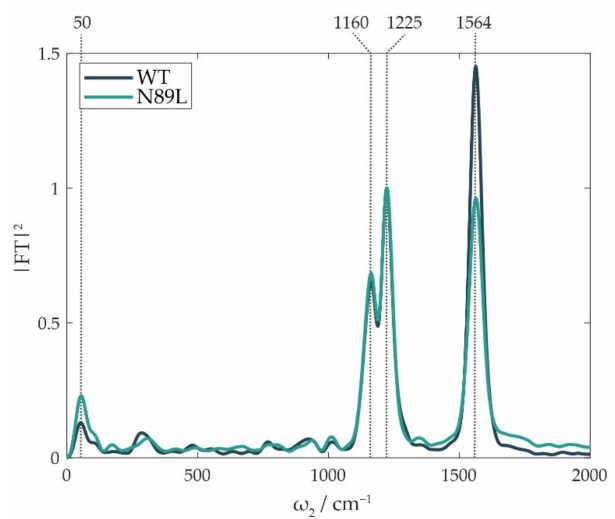
Figure 4. Fourier transform of the oscillating components of the 2DES signal, mediated along excitation and detection frequency axes. They are plotted as square moduli of the Fourier transform amplitudes and normalized on the intensities of the 1225 cm − 1